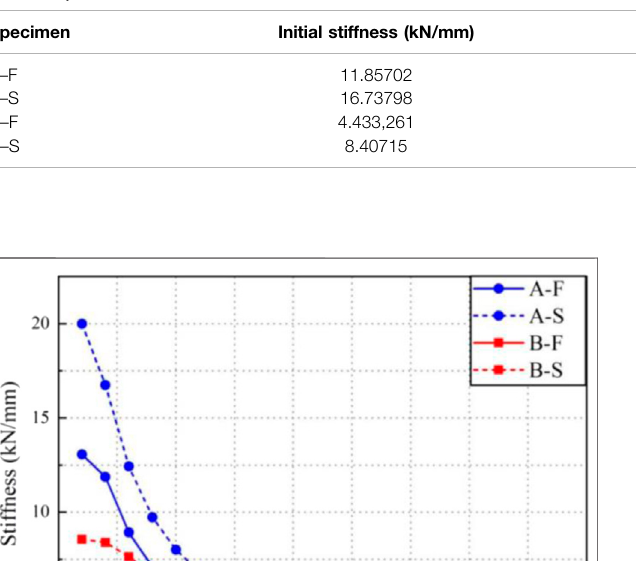
TABLE 4 | Mechanical behavior of a fi nite element.